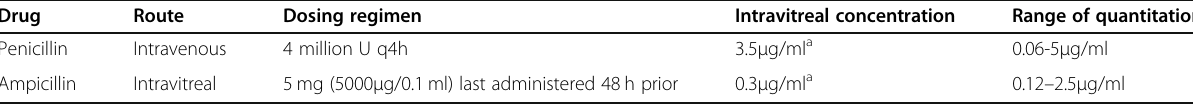
Table 1 Intravitreal Penicillin and Ampicillin Concentrations Drug